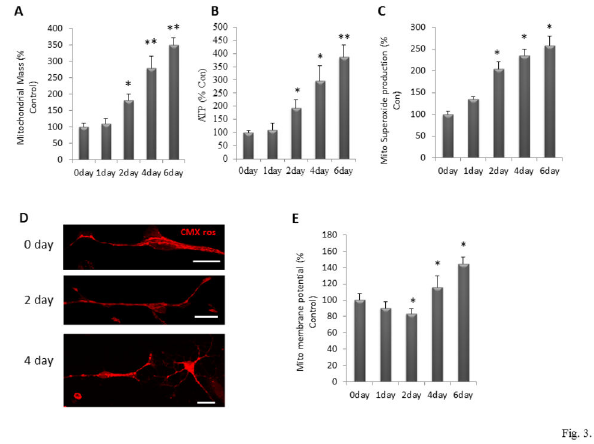
Figure 3. Mitochondrial mass and function changes in NPCs during differentiation. (A, B and C) Mitochondrial mass, measured by Mitotracker green loading (A), mitochondrial ATP content (B) and mitochondrial superoxide production, evaluated by MitoSOXred loading (C) are normalized by protein concentration in differentiated cells. (D) Mitochondrial membrane potential (∆Ψm) was imaged by mitoCMXros loading in NPCs on differentiation days 0, 2 and 4. Bar = 20 µm. (E) Mitochondrial membrane potential (∆Ψm) was determined by the ratio of MitoCMXros to Mitotracker green intensity. Values are expressed as a percentage of the mean of NPCs at day 0 (n = 4 separate experiments performed on NPCs cultured from 4 pregnant mice) *p<0.05, **p<0.001 compared to the values of NPCs at day 0.